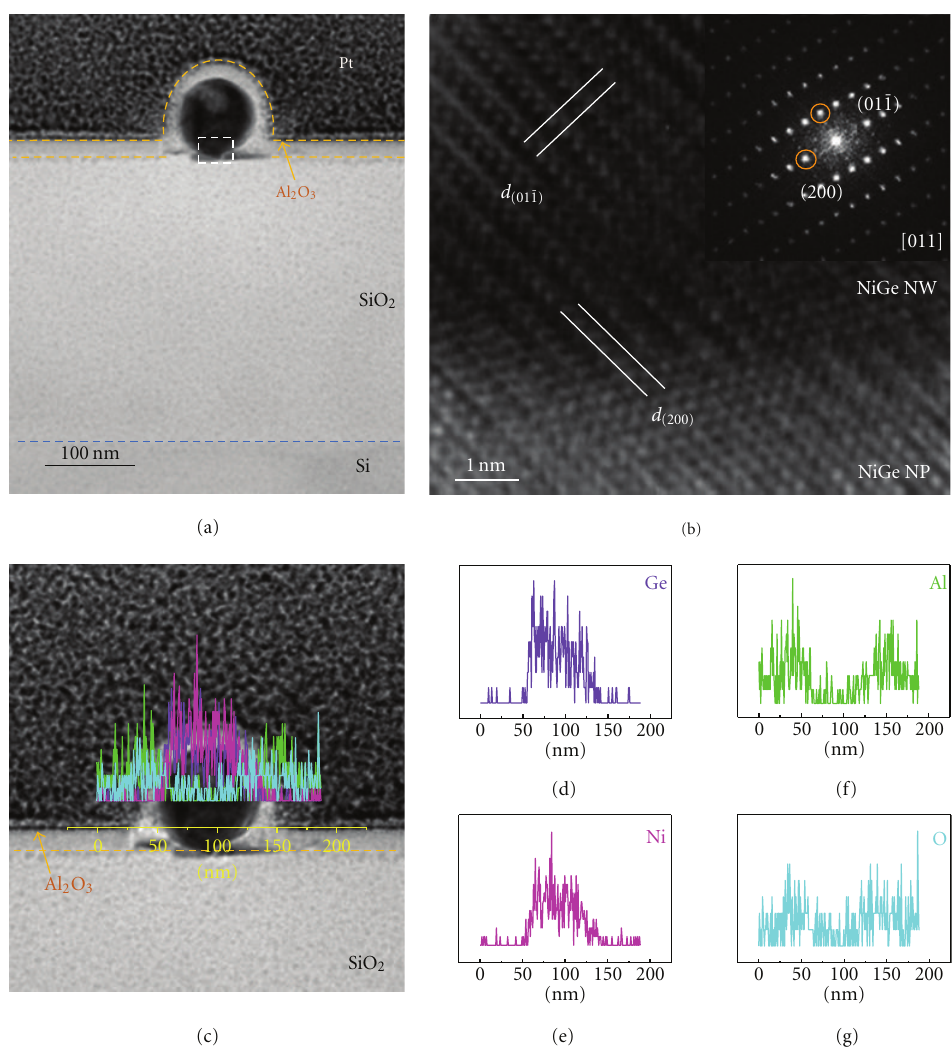
Figure 6: Cross-sectional TEM study of a Ni-Ge nanowire device on a SiO 2 /Si substrate cut with FIB. (a) Low-magnification cross-sectional TEM image of the NiGe region. The 20 nm thick Al 2 O 3 film provides a conformal capping on the device surface and germanide nanoparticles are clearly observed as they segregated underneath the nanowire, the region that is not covered by Al 2 O 3 . (b) Lattice-resolved HRTEM image of the interface between the formed NiGe nanowire (NW) and the segregated NiGe nanoparticle (NP), as indicated by the white rectangle in Figure 5(a). The inset shows the corresponding FFT pattern. The labeled lattice spacings for NiGe are: d (01-1) = 0 . 295 nm and d (200) = 0 . 269 nm. (c) Cross-sectional TEM image with the line-scan profiles of Ge, Ni, Al and O atoms. (d)–(g) The individual line-scan profile of Ge, Ni, Al, and O atoms, respectively, The Ni/Ge ratio is about 1 :1. Reproduced from